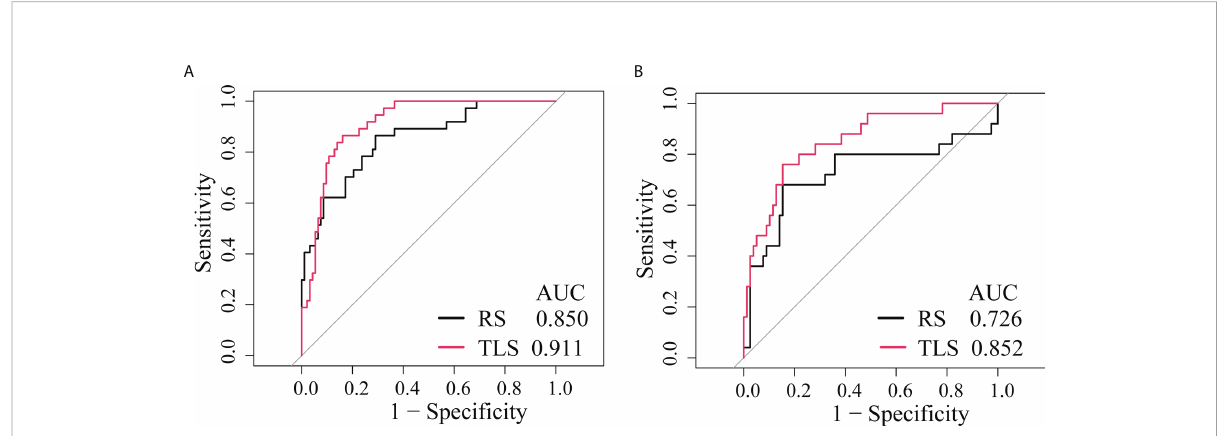
FIGURE 4 ROC curves of the prediction models. (A) Training cohort. (B) External validation cohort. RS, radiomics signature; TLS, transfer learning